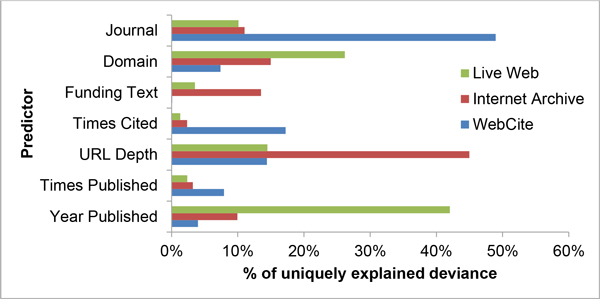
How important is each predictor in predicting whether a URL is available? This graph compares what portion of the overall deviance is explained uniquely by each predictor for each of the measured outcomes. A similar list of predictors (differing only in whether the first or last year a URL was published) without interaction terms was employed to construct 3 logistic regression models. The dependent variable for each of the outcomes under study (Live Web, Internet Archive and WebCite) was availability at the time of measurement. Unique deviance was calculated by dropping each term and measuring the change in explained deviance in the logistic model. Results were then expressed as a percentage of the total uniquely explained deviance for each of the 3 methods.